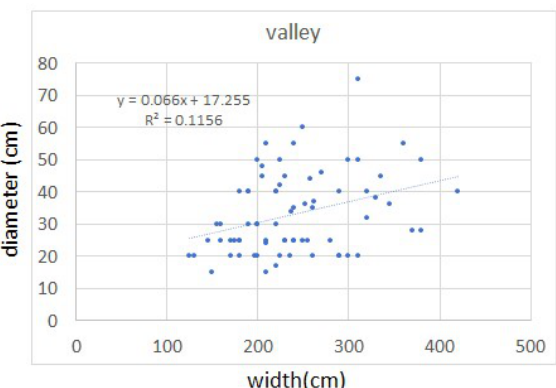
Figure 8 . Relationship between diameter and width of roots in valley